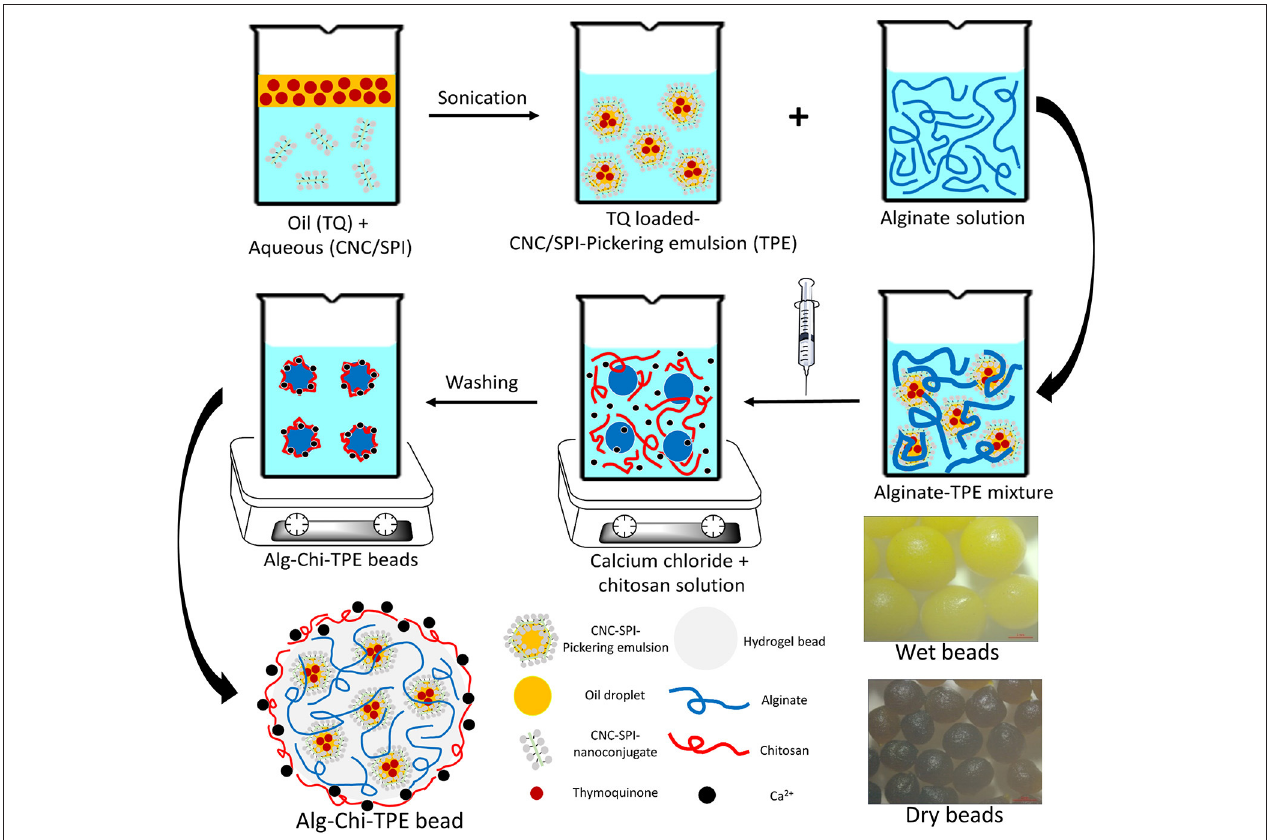
FIGURE 1 | The schematic illustration of the preparation of thymoquinone loaded alginate-chitosan beads by immobilized CNC/SPI-stabilized Pickering emulsion.